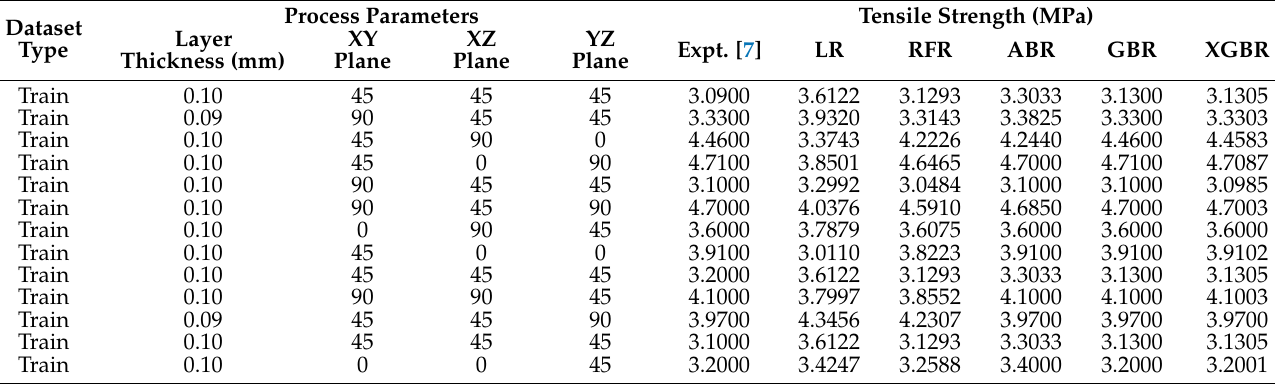
Table A2. Predicted tensile strength values by different ML algorithms for case study